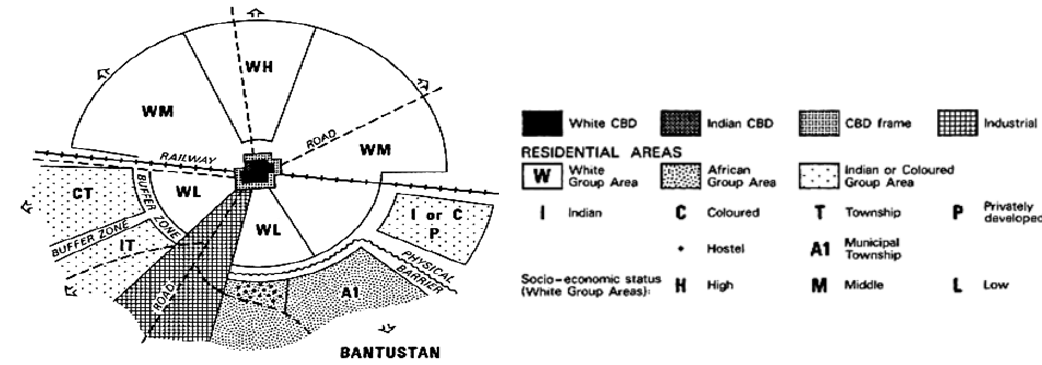
Figure 1: The original Apartheid city model Source: Davies (1981:64).